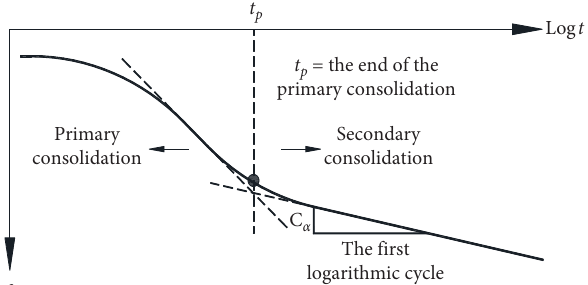
Figure 4: Diagram of the division of the primary consolidation and the secondary